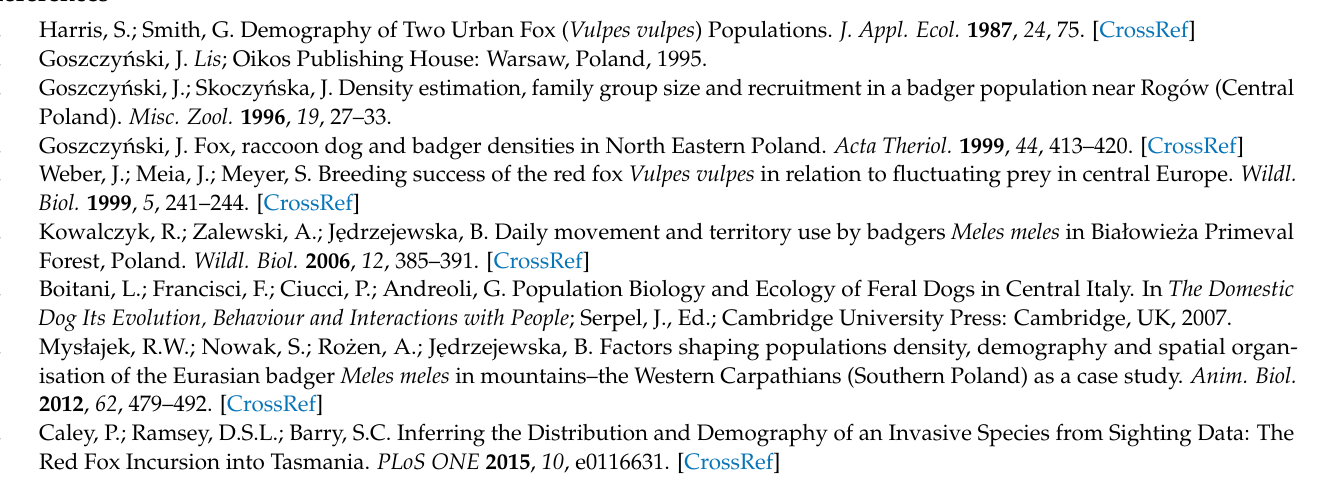
Table S3. Results of the Mann-Whitney pairwise test (U test value and p value) for comparisons of the estimated density of badgers (juveniles); Table S4. Results of the Mann-Whitney pairwise test (U test value and p value) for comparisons of the recruitment of badgers (N juveniles per N of